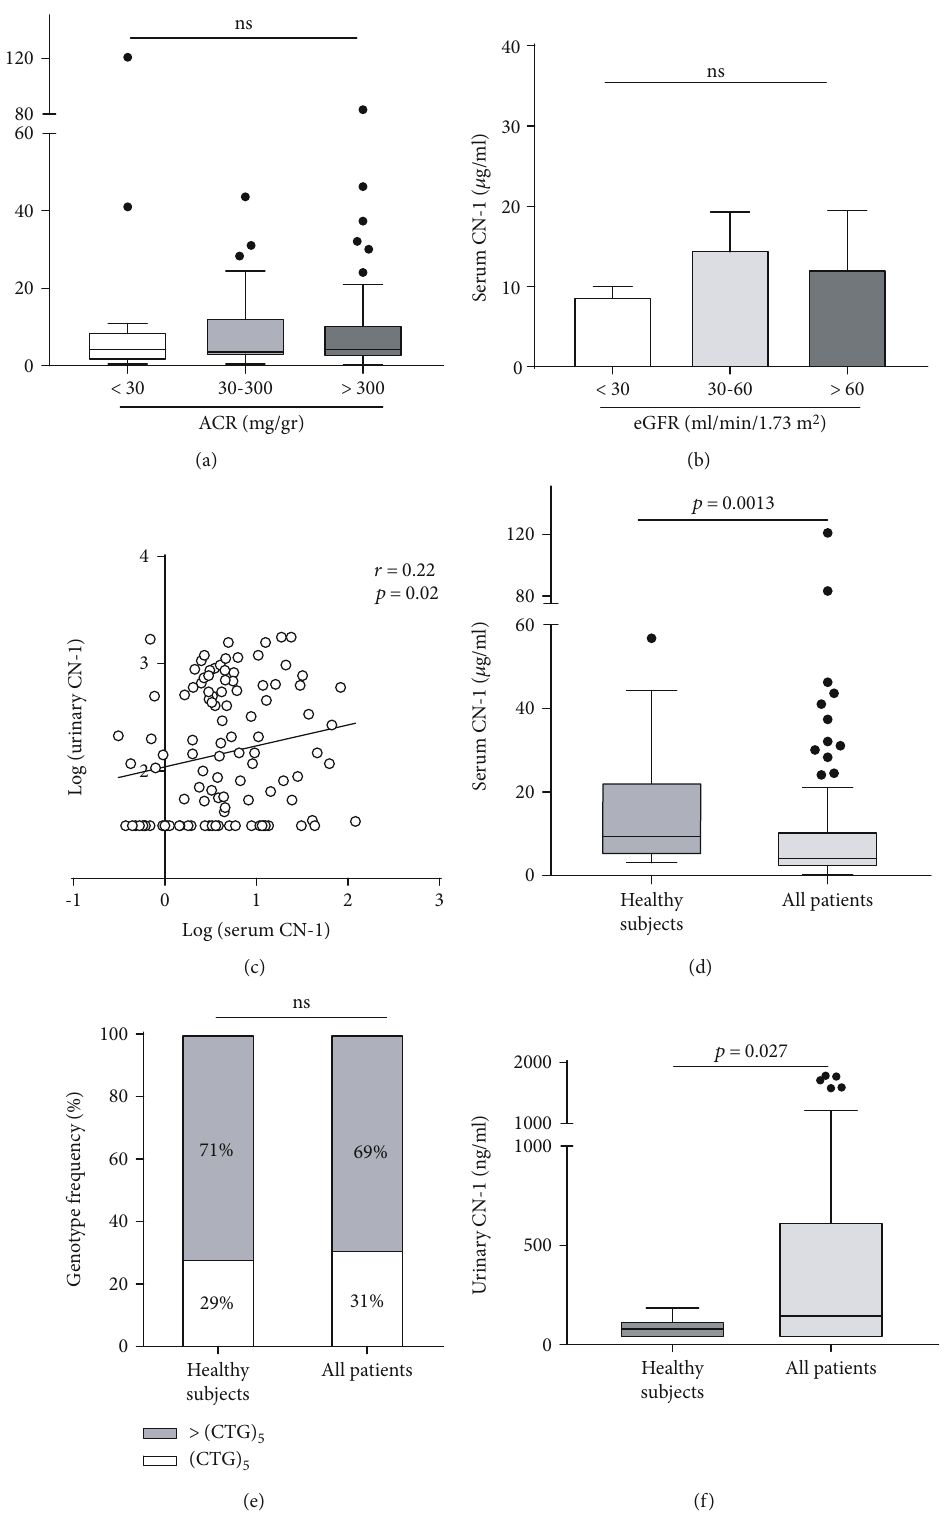
Figure 2: (a) Distribution of serum CN-1 concentrations in all the studied patients ( n = 111 ) according to ACR in normoalbuminuria ( n = 20 ), microalbuminuria ( n = 33 ), and macroalbuminuria ( n = 58 ). Boxes and whiskers represent the median and IQR. (b) According to eGFR in severely decreased ( n = 72 ), mildly decreased ( n = 23 ), and preserved eGFR ( n = 16 ). (c) Spearman correlation of serum CN-1 [log (serum CN-1]) and urinary CN-1 [log (urinary CN-1)] concentrations in all patients ( n = 111 ). (d) Patients ( n = 104 ) display lower serum CN-1 concentrations in comparison to healthy subjects ( n = 24 ). (e) Di ff erences are not related to the distribution of the homozygous CNDP1 (CTG) other genotypes ( > CTG) ( p = ns ). (f) Patients ( n = 104 ) have higher urinary CN-1 levels compared to the healthy group ( n = 24 5